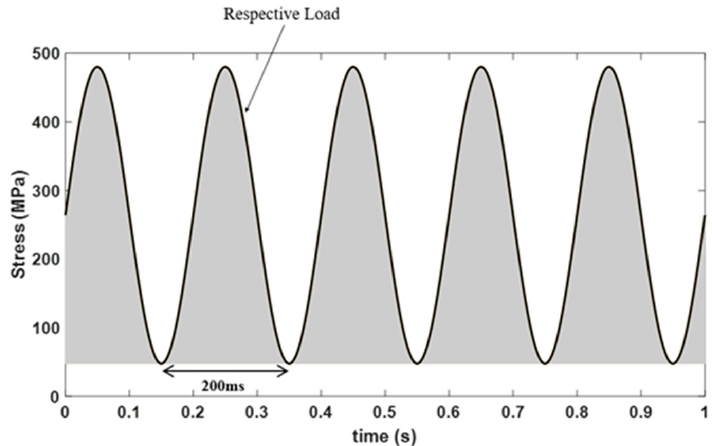
Figure 20. Fatigue loading for the coupon specimen.